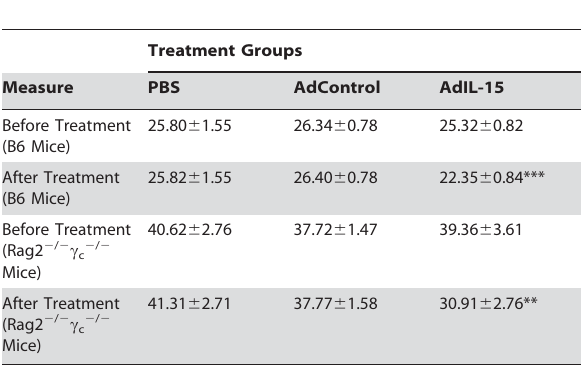
Table 1. Characteristics of mice before and after IL-15 treatment.